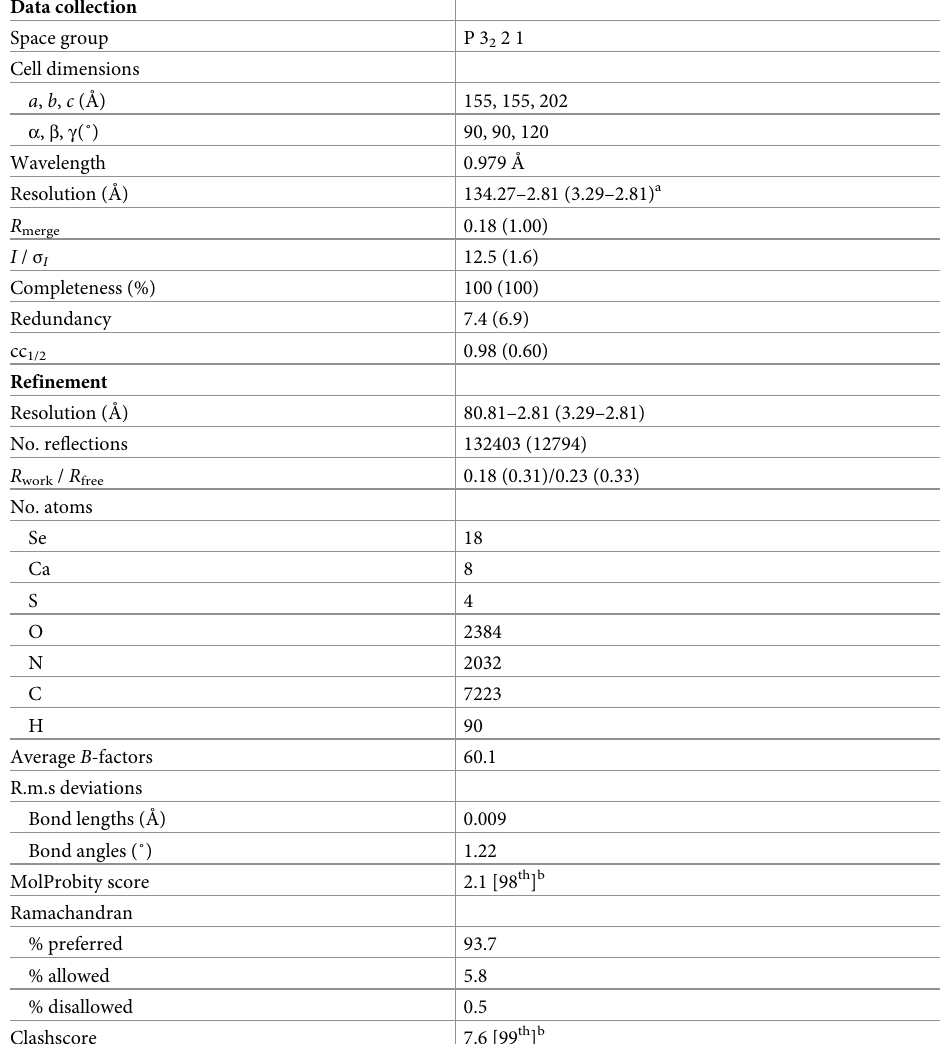
Table 1. Data collection, phasing and refinement